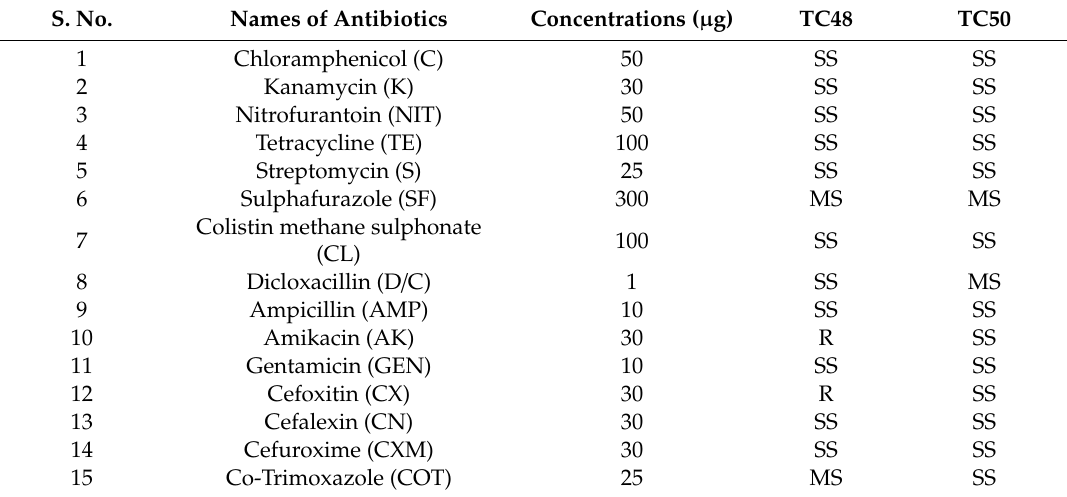
Table 5. Antibiotic sensitivity patterns of TC48 and TC50—in